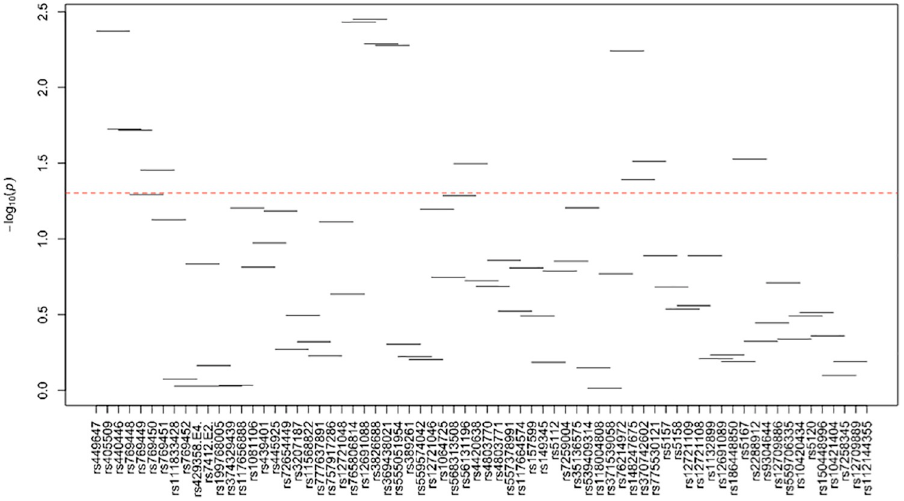
Fig 6. Plots of haplotype-based association analysis results for TG in NHWs. Horizontal lines represent the 4-SNP windows. X-axis direction shows the SNPs genotyped in the regions based on the order of APOE , APOC1 , HCR1 , HCR2 , APOC4 and APOC2 while the Y-axis shows the–log (global p-value) with red line representing the p-value threshold (P =